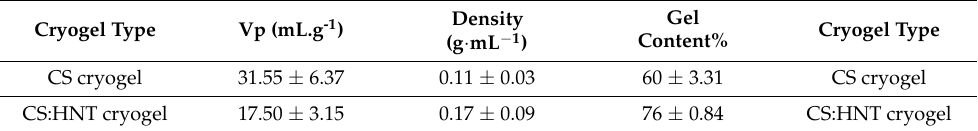
Table 1. Pore volume (V p ), density and gel content of CS cryogel and CS:HNT cryogel.